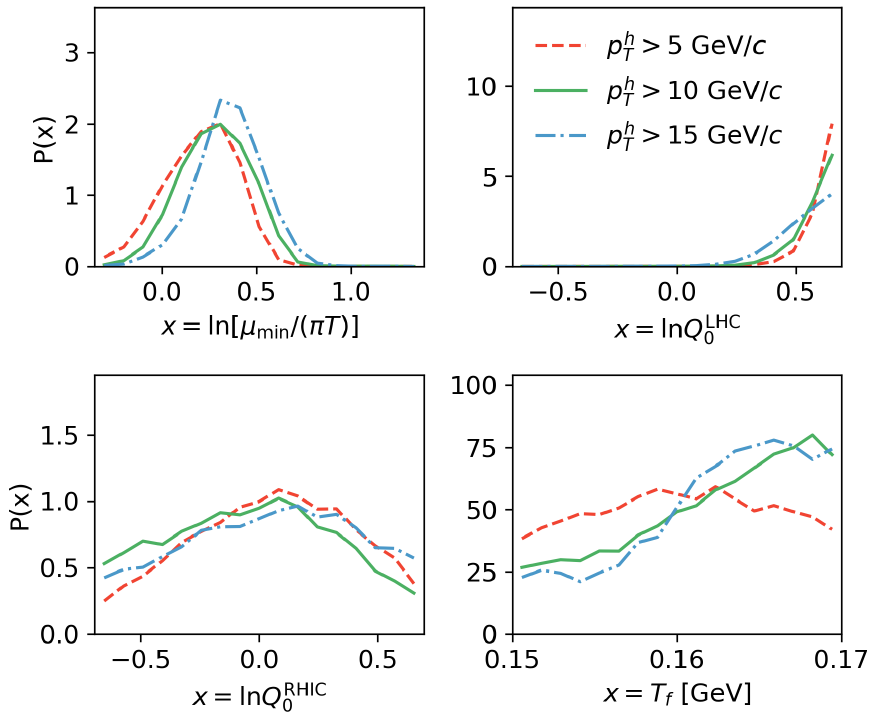
Figure 20 . Test the sensitivity of posterior to the p T cut-off on hadron R AA data. We only show the posterior marginalized on each individual parameter. Different color and line-shape combinations correspond to different values of cut-off p hadron > 5 , 10, and 15 GeV/ c respectively. T